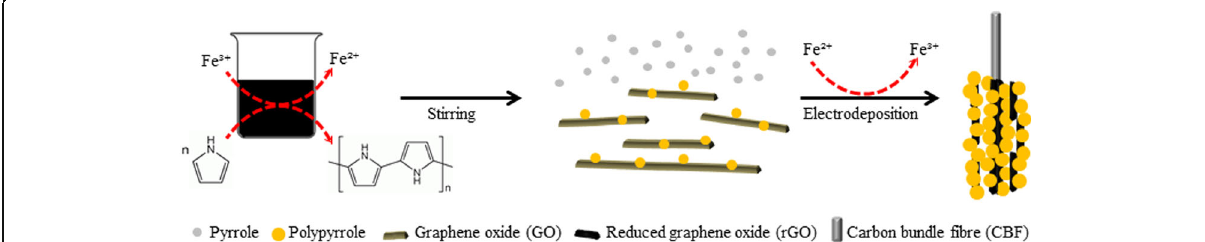
Scheme 1 Schematic diagram of the synthesis process of